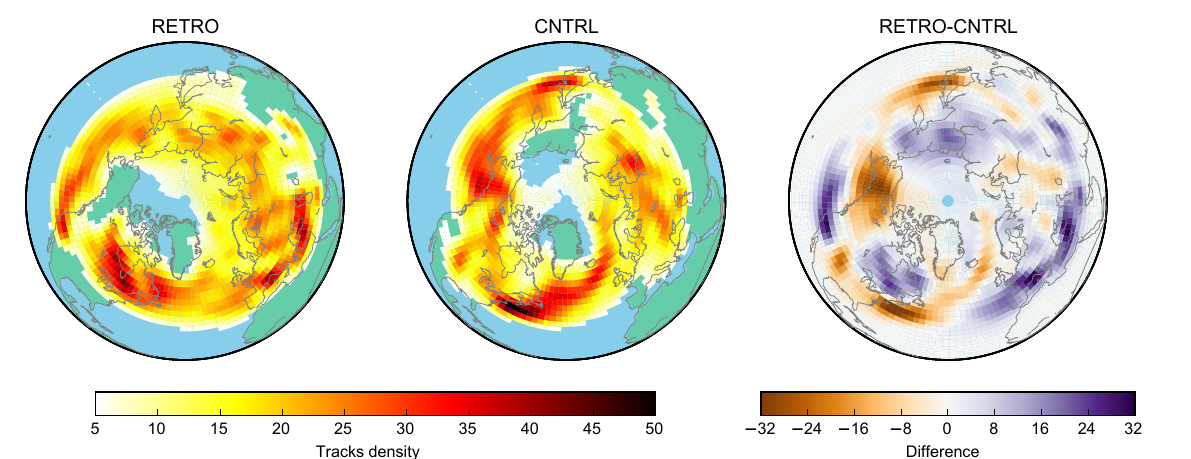
Figure 4. Track density (number of tracks per season for a unit area equivalent to a 5 ◦ spherical cup) computed for the Northern Hemisphere during the December–January–February (DJF) season. The tracking is performed using 2-hourly mean sea level pressure (MSLP) data; storms are defined as local minimum of MSLP and are tracked during their lifetime using the methodology described in Hoskins and Hodges (2002). The data are seasonally averaged over the last 100 years of each simulation. In the first two plots on the left track, density for RETRO and CNTRL is shown; values below 5 are masked for the sake of visualization. Shown in the rightmost plot is the difference between RETRO and the CNTRL simulation without any masking applied. For the Southern Hemisphere version of this figure, see Fig.